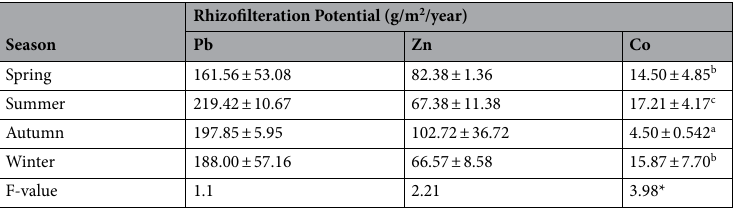
Table 3. Seasonal variations of P. stratiotes rhizofilteration potentials of heavy metals in drainage water. F-values represent ANOVA and letters (post-hoc Duncan test) for significant levels of seasonal variations. * p ≤ 0.05. Small letters “a”, “b” and “c” indicate to significant variation of Post-hoc Duncan test.